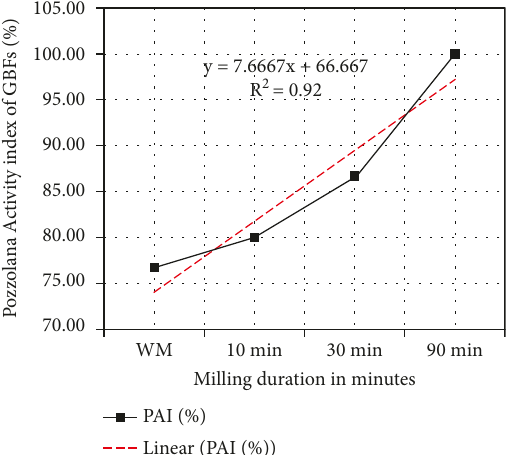
Figure 8. The graph was plotted for milling duration (in minutes) versus pozzolana activity index of GBFS (in %).